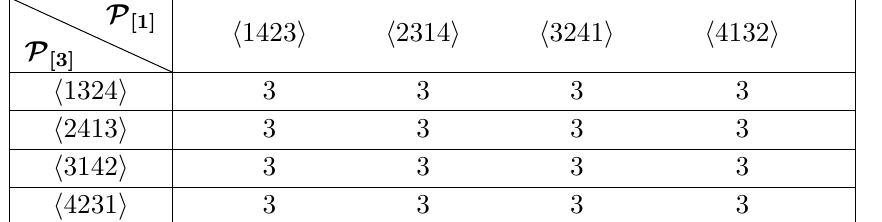
Table 19. {P} 3 − {P} 1 two-point correlator values.